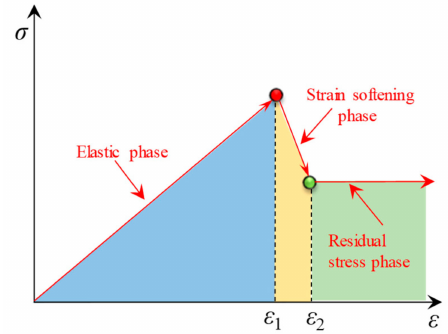
Figure 6. Strain softening model of coal and rock mass.